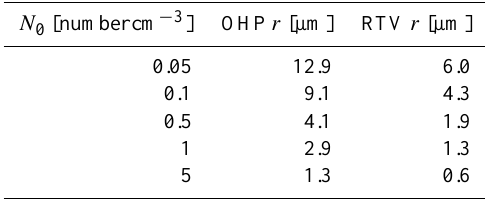
Table 5. Estimates of the principal error sources of the mean sed- imentation velocity ( v s ) for the considered test case. Each uncer- tainty is tabulated in terms of quantified or qualitatively estimated relative